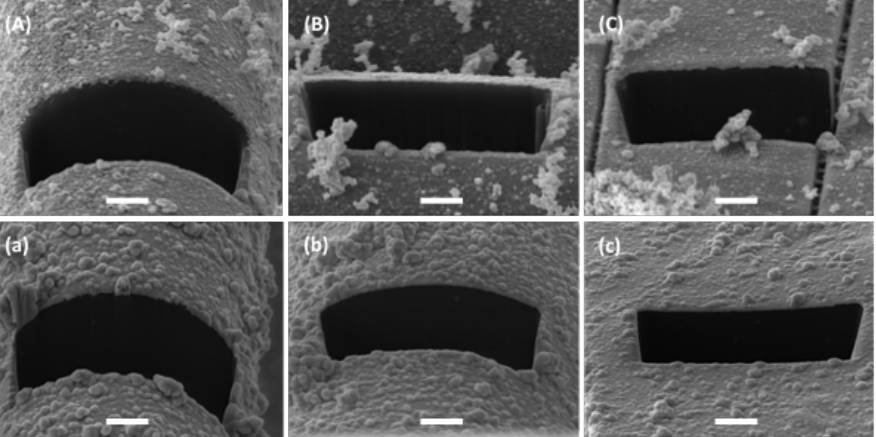
Figure 3. High magnification SEM images at the cross-section prepared by focused ion beam (FIB) for the determination of the coated layer thickness. Fabrics produced by 55% of viscose and 45% polyester ( A ), by 100% polyestersulfone ( B ), a taffeta lined and calendered polyamide textile ( C ) coated with copper, respectively. The corresponding fabrics coated with nickel are presented in ( a – c ), respectively. Scale bar for all samples: 2 µ